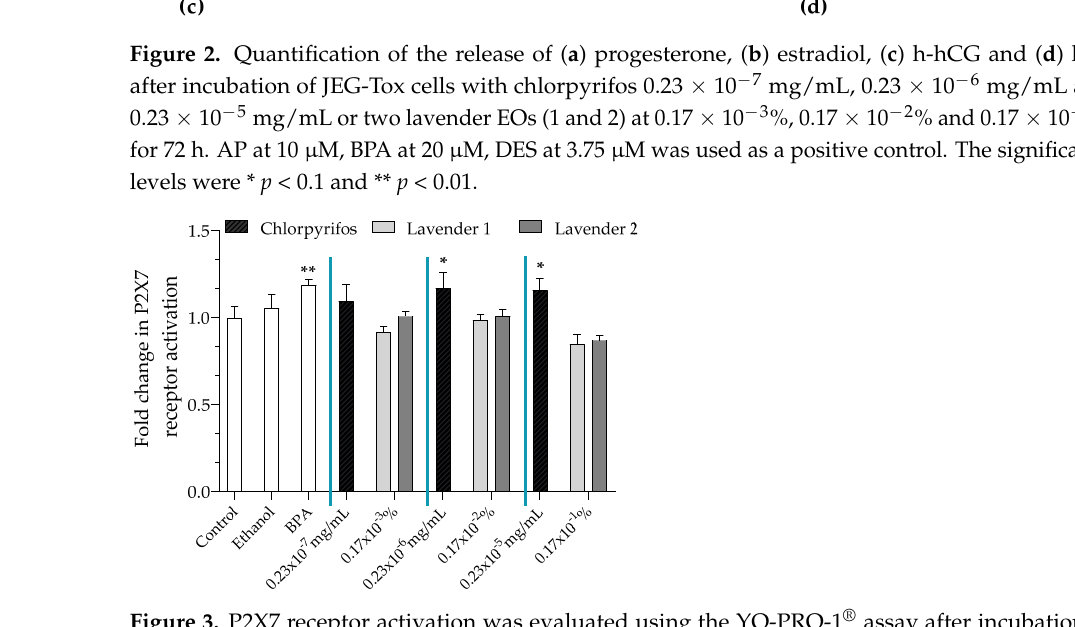
Figure 3. P2X7 receptor activation was evaluated using the YO-PRO-1 ® assay after incubation of JEG-Tox cells with chlorpyrifos at 0.23 × 10 − 7 mg/mL, 0.23 × 10 − 6 mg/mL and 0.23 × 10 − 5 mg/mL or two lavender EOs (1 and 2) at 0.17 × 10 − 3 %, 0.17 × 10 − 2 % and 0.17 × 10 − 1 % for 72 h. BPA at 20 µM was used as a positive control. The significance levels were * p < 0.1 and ** p <